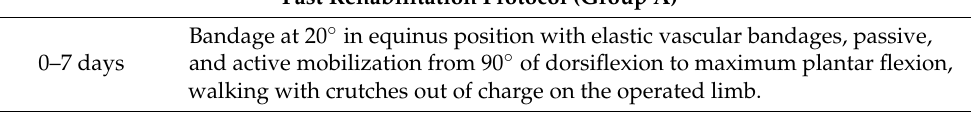
Table 2. Fast rehabilitation protocol applied to group A. Fast Rehabilitation Protocol (Group A)